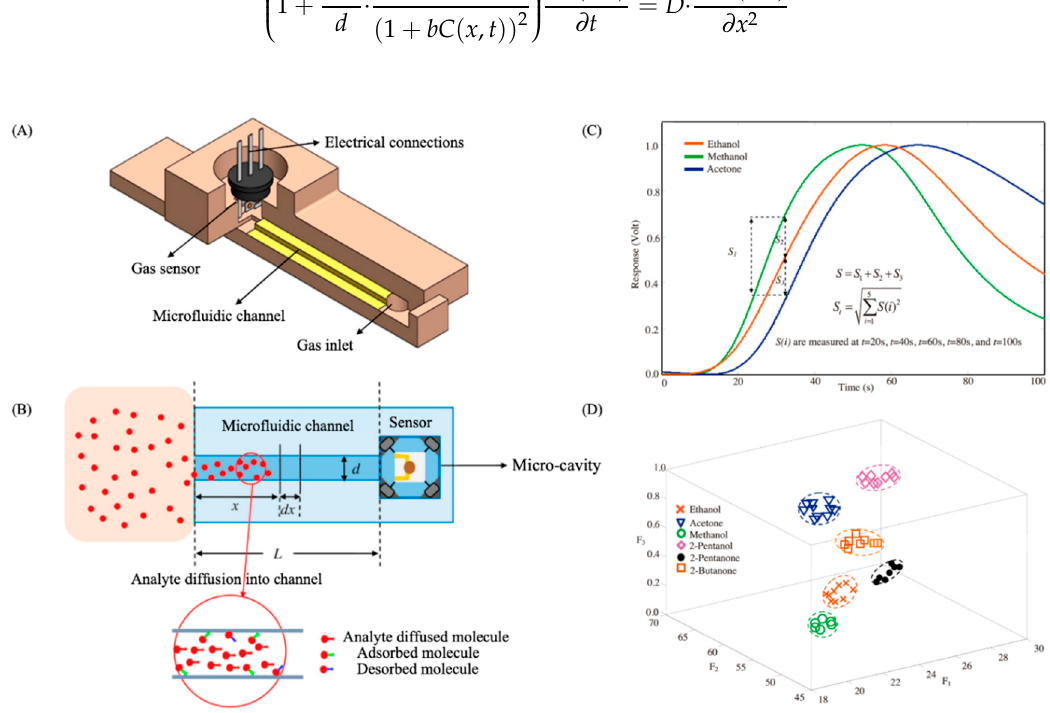
Figure 11. ( A ) Schematic diagram of the 3D-printed microfluidic device with a square-based cross-section. ( B ) Schematic representation of the di ff usion and physisorption e ff ect of gas molecules along the microfluidic channel (red dots). ( C ) Normalized transient response of the microfluidic-based device towards three different VOCs (ethanol, methanol, and acetone). The output signals are shifted onwards due to the selectivity provided by the microfluidic channel. ( D ) 3D feature space representation of six different analytes at eight different concentration levels (from 250 to 4000 ppm). Reprinted and modified with permission from ref. [254]. Copyright 2016, Elsevier.